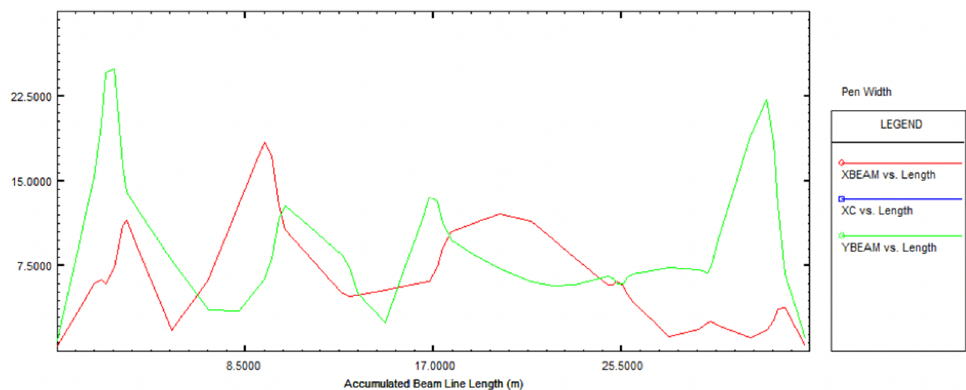
Figure 4. Beam envelope (mm) as a function of the transport beam line length (m) from the end of the FRAISE line to the NUMEN target.